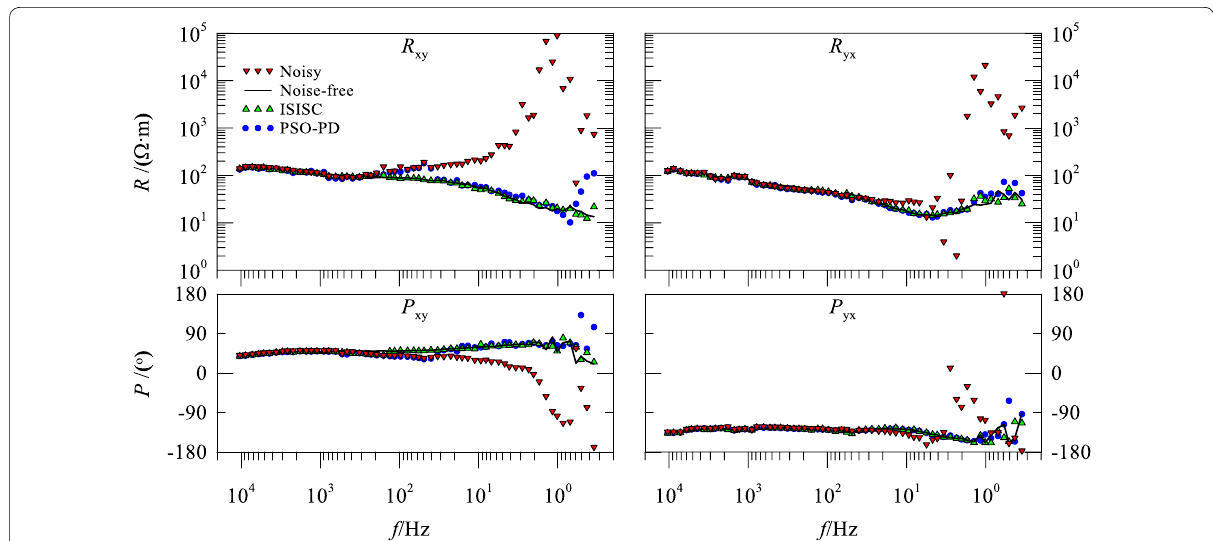
Fig. 6 Apparent resistivity and phase curves of the station ASY0002B. The upper panels are apparent resistivity curves and the bottom panels are phase curves. The red curves with inverted triangles represent the results obtained by all raw data sets D 1 and D 2 ; the black solid lines represent the results obtained using noise-free data set D 1 ; the green curves with triangles stand for the results achieved by data sets D 1 and D 2 but is de-noised by ISISC; the curves with blue circles stand for the results calculated from the data sets D 1 and D 2 , but filtered by the pulse dictionary-based method